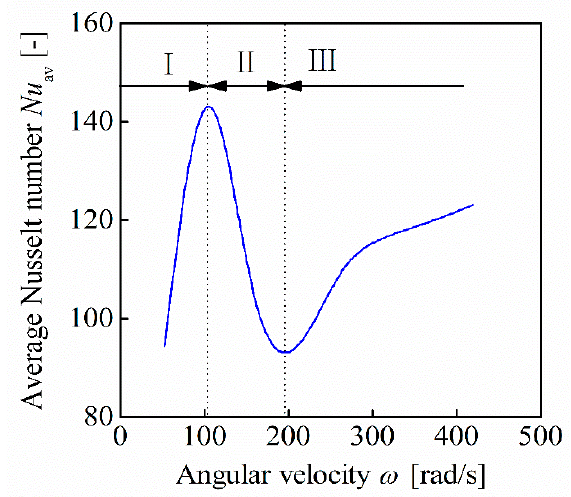
Figure14. Figure 14. Curve of the average Nusselt number on the stationary disk surface at different angular velocities.